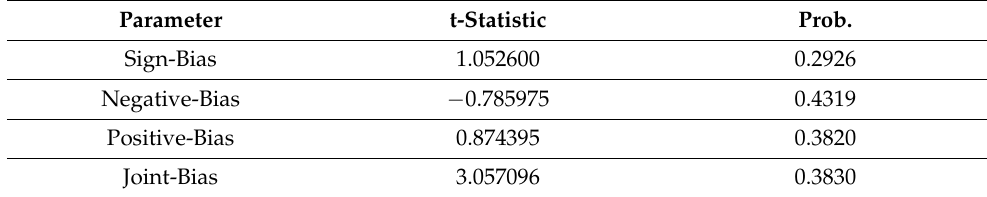
Table 9. Engle Ng Sign-Bias